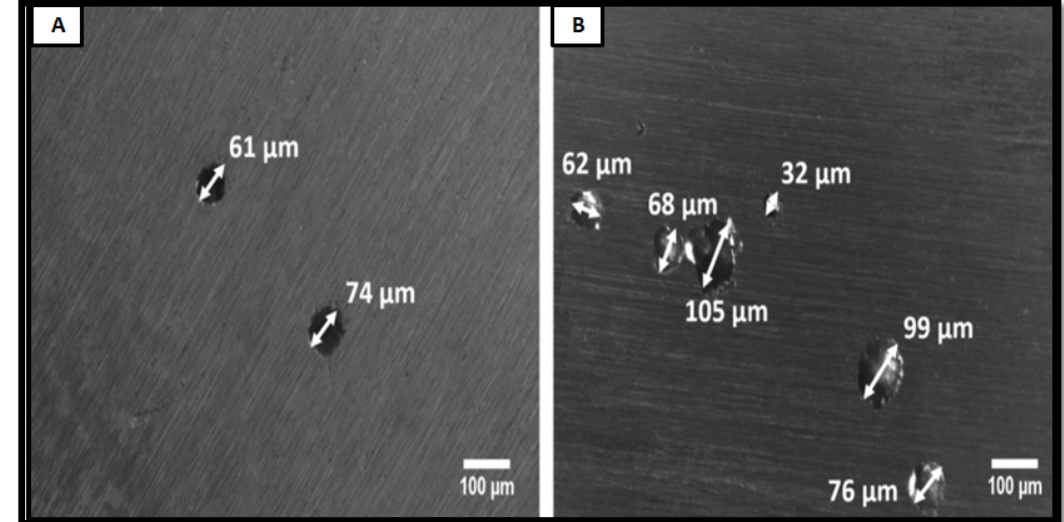
Figure 18. Pit formation in corrosion testing ( A ) SLM and ( B ) wrought SS316L [42].